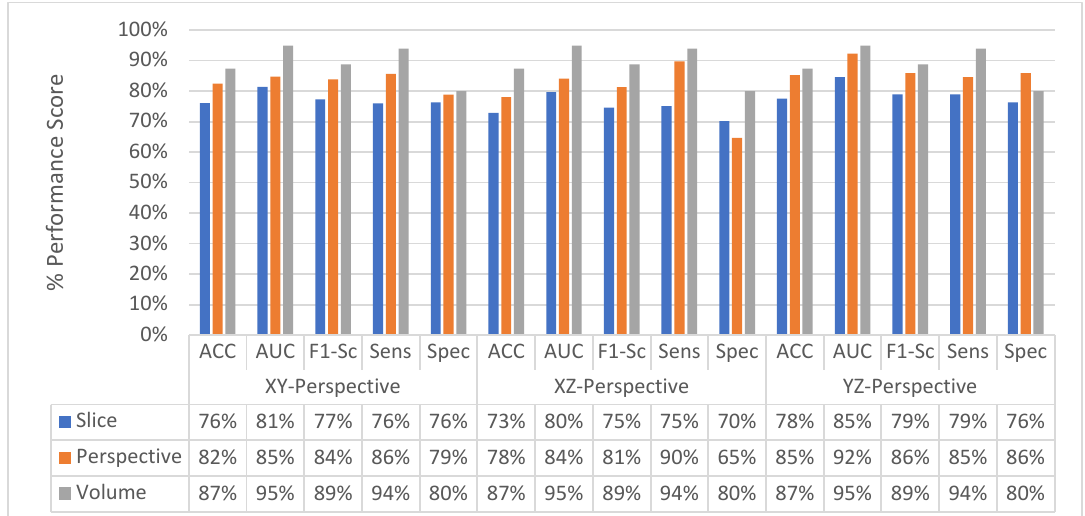
Figure 29. SFMPF model using LOG Image—change in classification performance for slice, perspec- tive, and volume-level classifications for each perspective.